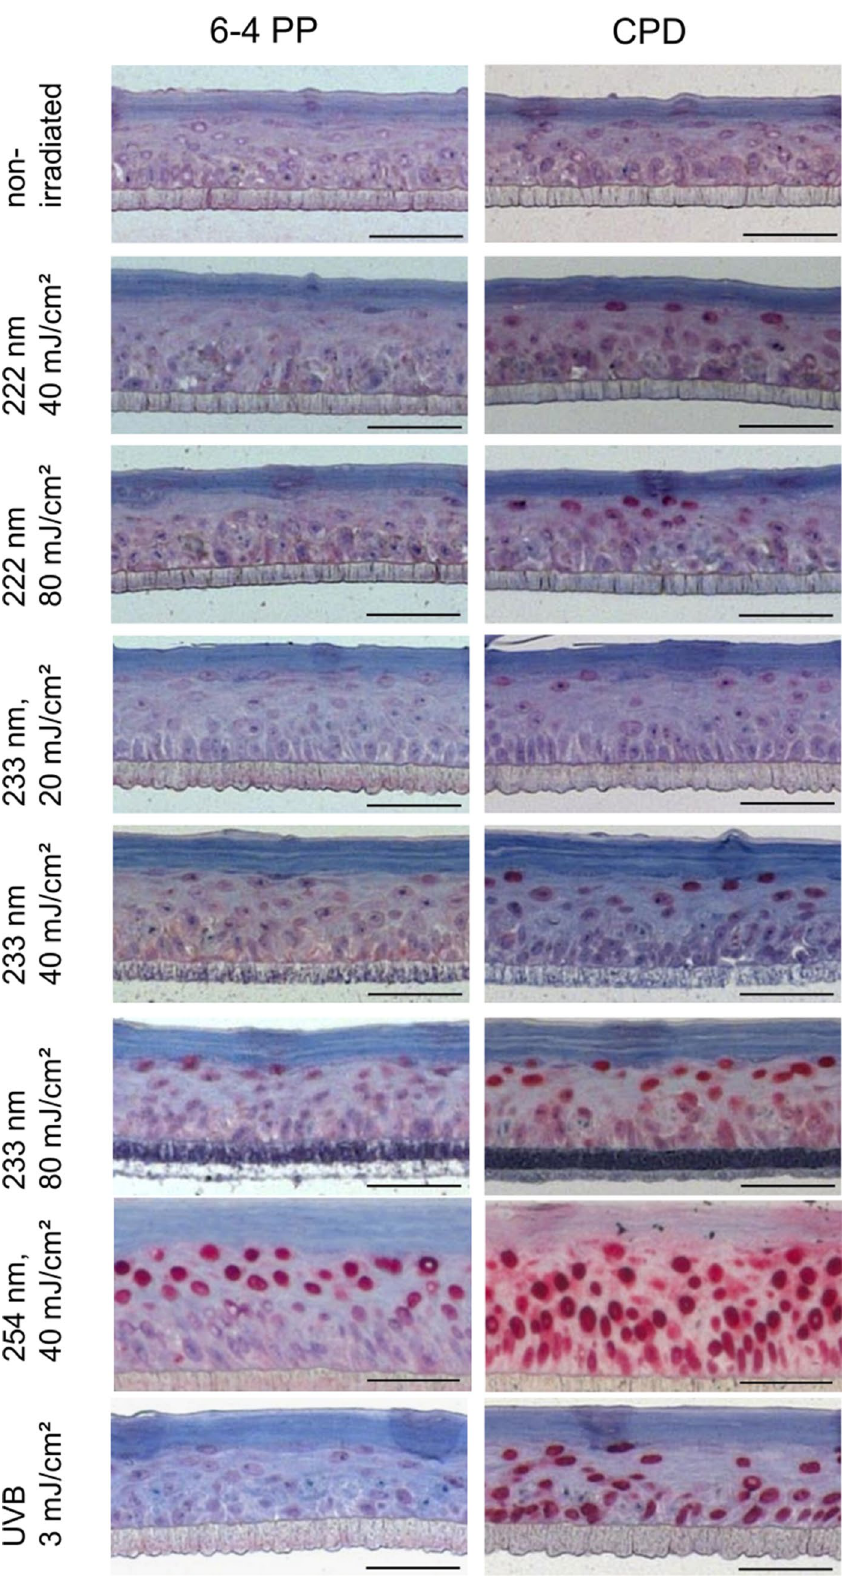
Figure 4. Representative images of histological analysis of DNA damage in RHEs. Paraffin sections are stained for 6-4PP (left column) and CPD damage (right column). Positive cells are stained in dark red. Non-irradiated RHEs (negative control) show no positive cells, while positive epidermal keratinocytes of RHEs irradiated with 40 mJ/cm 2 at 254 nm (positive control) were found even in the deeper layers of the epidermis. RHEs irradiated with 3 mJ/cm 2 UVB (0.1 MED) showed > 90% CPD damage throughout the whole epidermis. The CPD damage after 40 mJ/cm 2 irradiation at 222 nm and 233 nm only occurred at the uppermost layer of the epidermis. Scale bar: 50